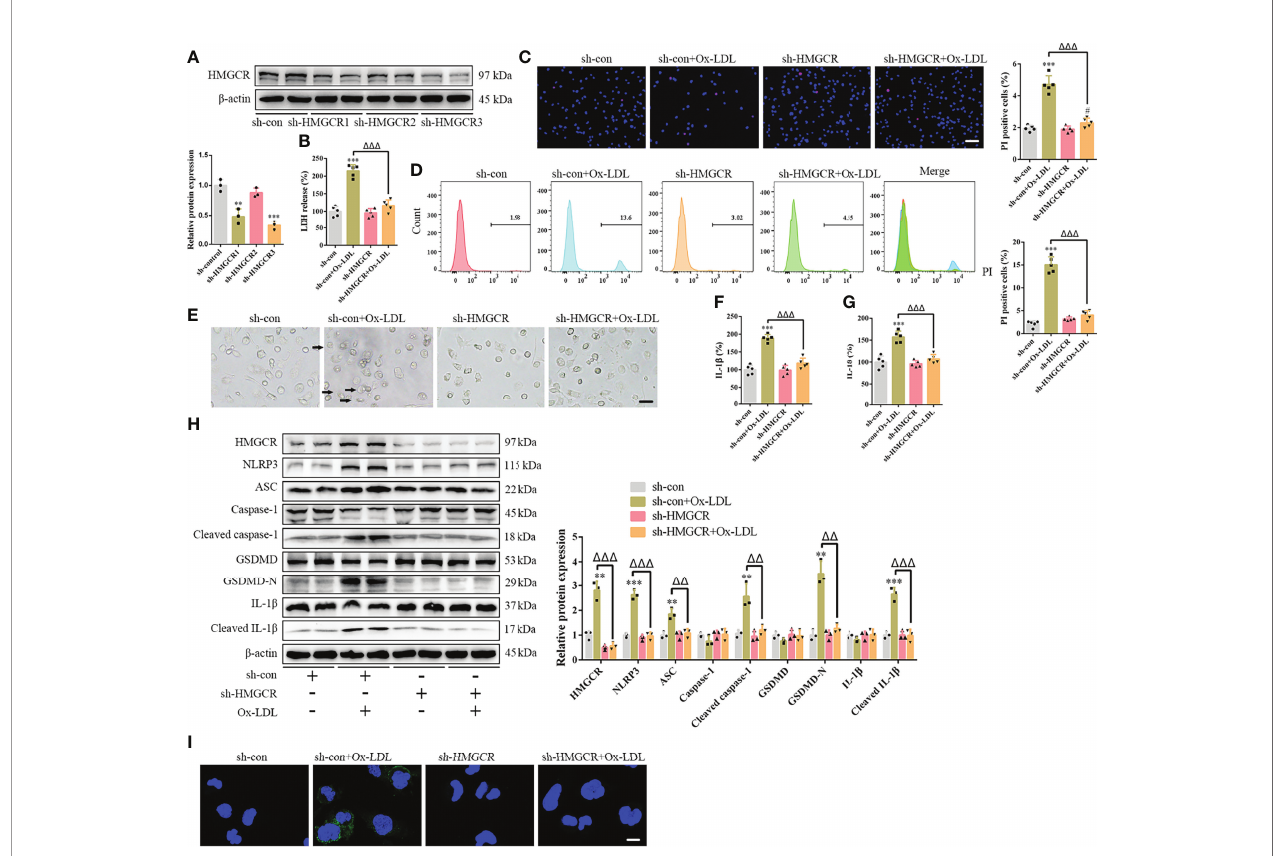
FIGURE 5 | HMGCR knockdown attenuates foam cell pyroptosis. (A) Western blotting con fi rmed HMGCR knockdown. (B) Lactate dehydrogenase release in the cell supernatants. (C) Hoechst 33342 (blue) and propidium iodide (red) fl uorescence staining showing cell membrane integrity. Scale bar, 100 m m. (D) Flow cytometry to detect pyroptotic cells. (E) Pyroptotic bubbles (arrow) observed through microscopy. Scale bar, 25 m m. (F, G) Enzyme-linked immunosorbent assay for the detection of IL-1 b and IL-18 levels in the cell supernatants. (H) Western blotting showing protein abundance. (I) Immuno fl uorescence staining showing the GSDMD-N activation. Scale bar, 12.5 m m. ** p < 0.01, *** p < 0.001, versus the sh-control group. # p < 0.05, versus the sh-HMGCR group. △△ p < 0.01, △△△ p < 0.001, versus the sh-control + ox-LDL